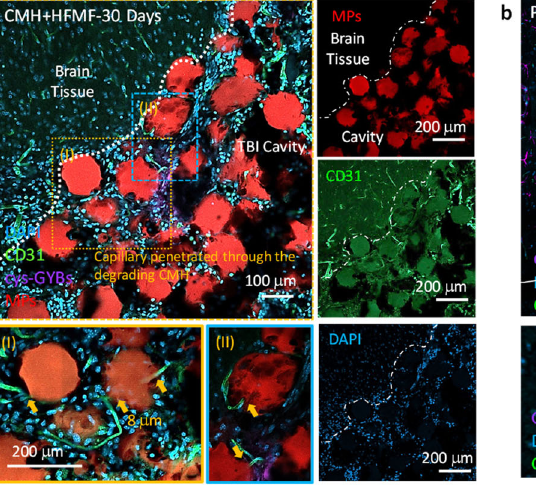
Fig. 6 | Endothelial cells (ECs) in fi ltrated and ingrowthed within channel net- work hydrogels from 30 days implantation in mouse. Fluorescence images of bloodvessels(CD31)ingreen),nucleic(DAPI)inblueandMBs(RITC)inredaround thetraumasiteat30dayspostsurgery. a ECsliningamicrochannelnetworkinvivo